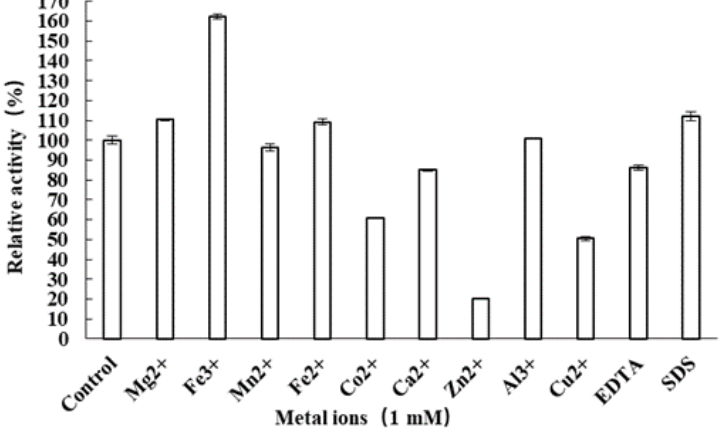
Figure 4. Effect of various metal ions on the β -D-fructofuranosidase of AlFFase3.